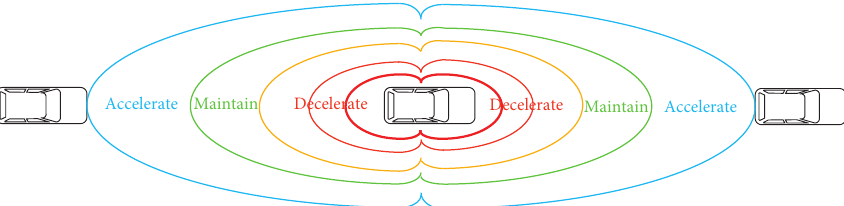
Figure 4: Vehicle maneuvers based on drivers’ psychological status.